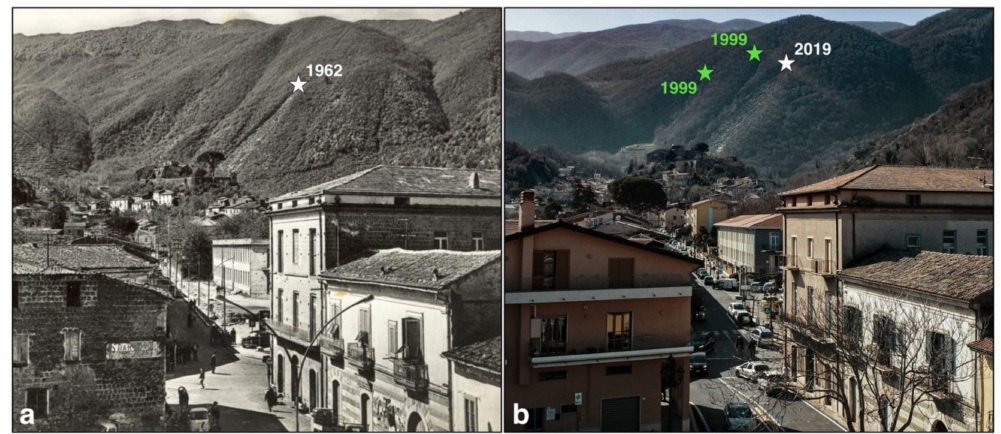
Figure 4. Some historical landslides (stars highlight the scar zones) of the Pizzone Mt., south of the S. Martino V.C. village: ( a ) photo taken in 1963, showing landslide of 1962; ( b ) photo taken in 2020, showing the landslides of 2019 and